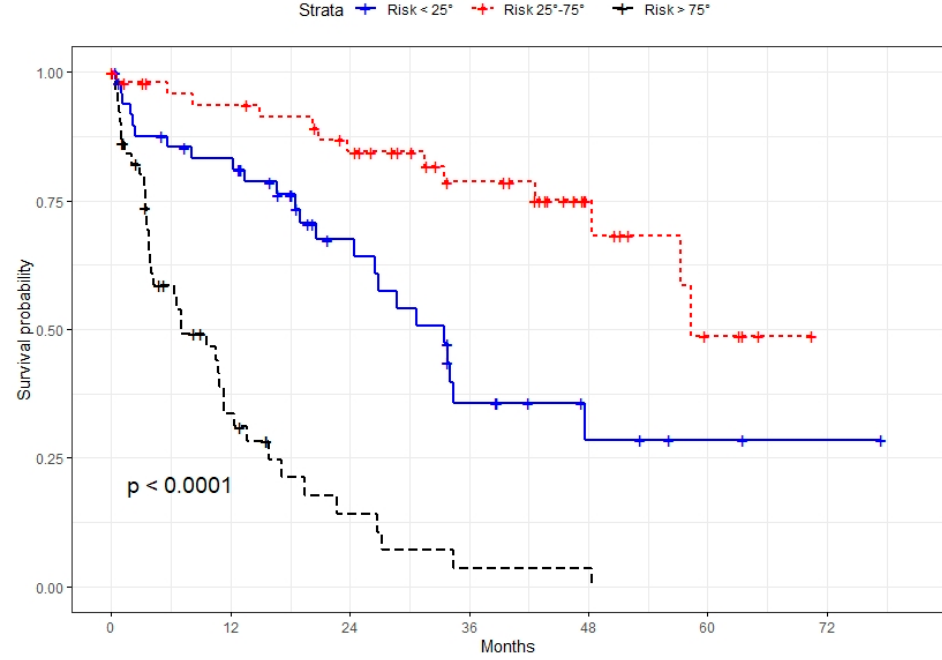
Figure 2. Observed survival of patients in the validation cohort grouped by 25 and 75 percentiles of the probability of survival (Log-rank test, p < 0.001).